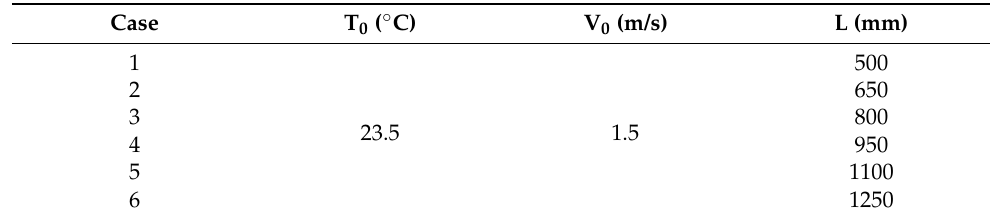
Table 5. Simulated